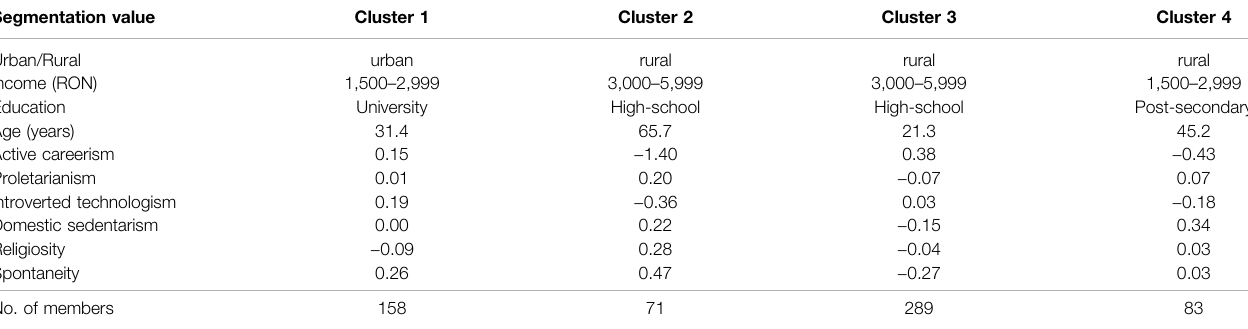
TABLE 4 | Segmentation of the household consumer market based on lifestyle and socio-demographic traits (average or median values). Segmentation